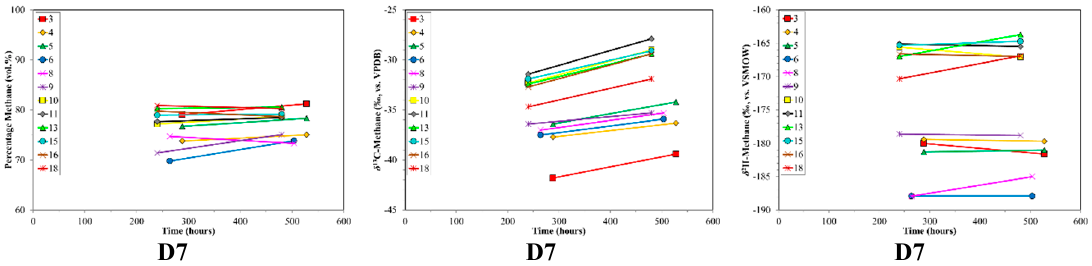
Figure 3. Time series of volume % methane, δ 13 C-CH 4 and δ 2 H-CH 4 for desorption samples sets (top to bottom) versus production time. Sample set D5 was not plotted due to insufficient data. Note the different scales between sample sets.